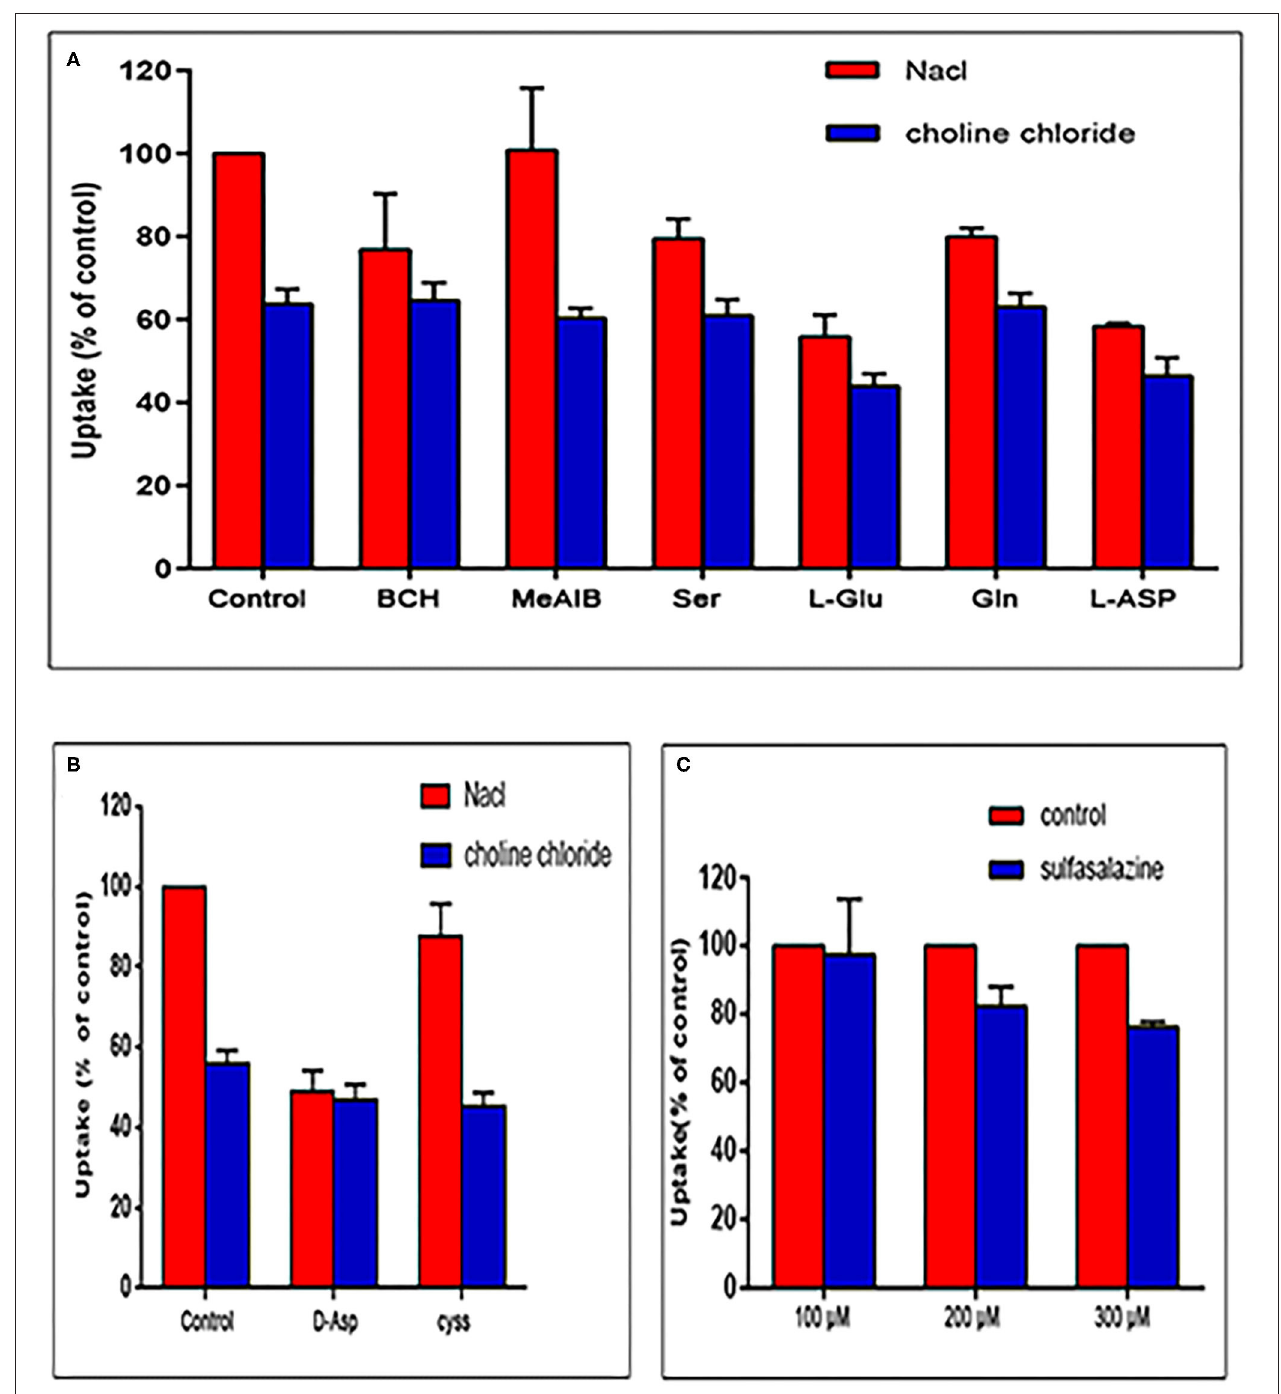
FIGURE 3 | Uptake of [ 18 F]AlF-NOTA-NSC-GLU in human HCC Hep3B cells in the competitive inhibition studies. (A) Uptake of [ 18 F]AlF-NOTA-NSC-GLU in human HCC Hep3B cells in the presence or absence of Na + by type of inhibitors. Values are given as percentage (mean ± SD, n = 15) of uptake in cells that were incubated with or without inhibitors, i.e., 2-amino-2-norbornane-carboxylic acid (BCH), α -(methylamino)isobutyric acid (MeAIB), serine (Ser), glutamine (Gln), L-glutamate (L-Glu), and L-aspirate (L-Asp) in NaCl (Na + -containing) or choline chloride (no Na + ) buffer. (B) The inhibitors included D-aspirate (D-Asp) and cystine (cyss). (C) The inhibitor, sulfasalazine, was divided into three concentrations: 100, 200, and 300 µ